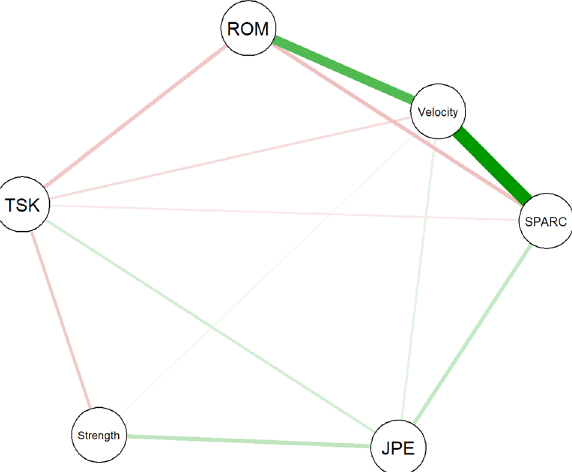
Figure 1. Network estimated from neuromuscular/kinematic features ( JPE Joint position error, ROM Range of motion, SPARC Spectral arc length; Strength; Velocity , velocity of neck movements) and fear of motion ( TSK ). Positive and negative partial correlation coefficients are displayed in green and red, respectively. The thickness of the edges represents how strong the relationships between nodes